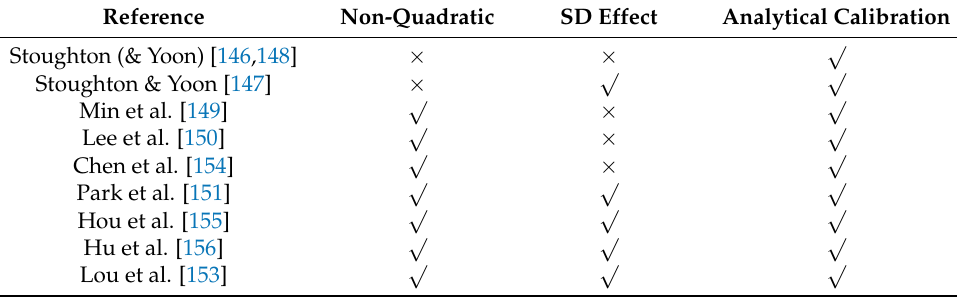
Table 2. The advanced NAFR constitutive